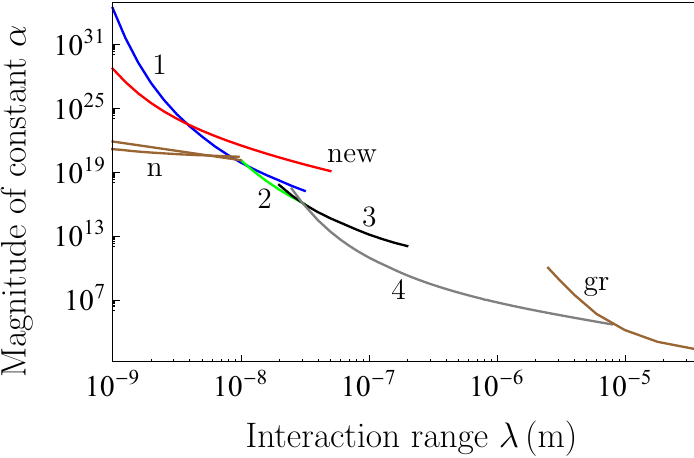
Figure 7. The constraints on Yukawa-type correction to Newton’s gravitational law following from recent measuring the Casimir force at nanometer separations (line labeled “new”), from experiments on neutron scattering (lines labeled “n”), and from the Cavendish-type experiment (line labeled “gr”) are shown as functions of the interaction range. The lines 1–4, which also indicate the strongest constraints within the respective interaction ranges, are reproduced from Figure 3. The regions above each line are excluded and below each line are